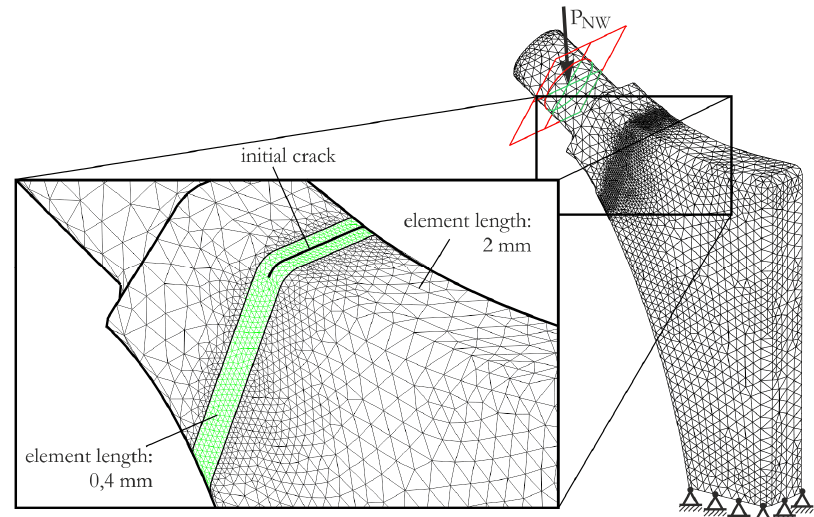
Figure 6: FE-model of the implant with its boundary conditions and meshing details.